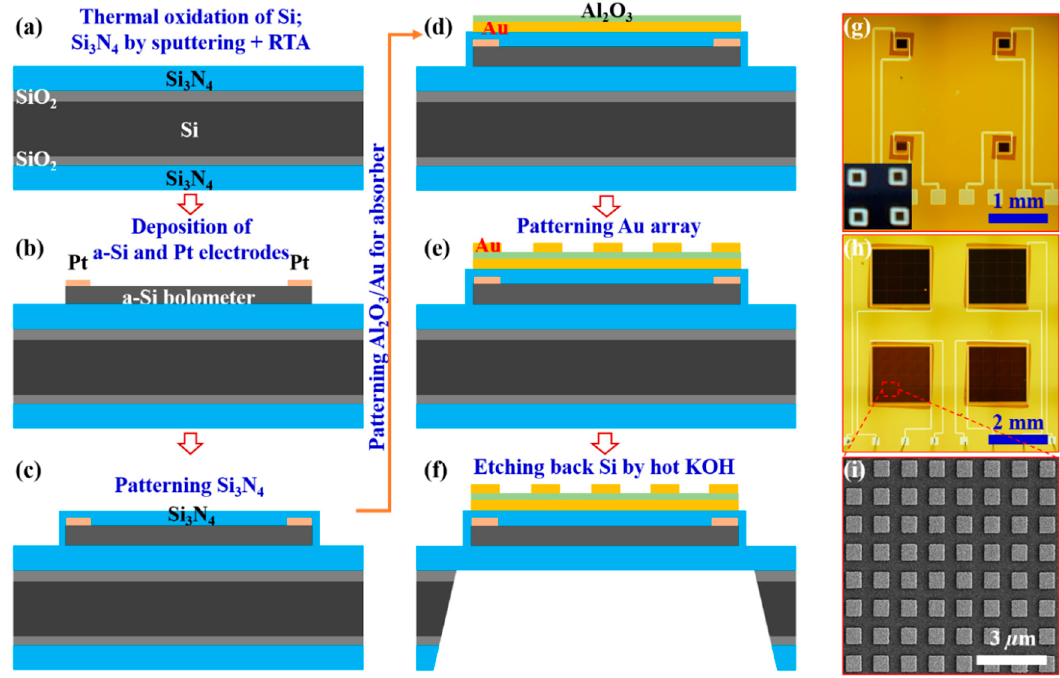
Figure 3. ( a )–( f ) Fabrication procedure of the MEMS-based wavelength-selective absorbers. ( g ) and ( h ) Top-view optical microscope images of the fabricated MEMS wavelength-selective bolometers with different square antenna sizes of the individual sensors. The inset in ( g ) reveals a photo of the MEMS-based quad-wavelength bolometer with the clear transparent Si 3 N 4 membrane around each bolometer. ( i ) Top-view SEM image of the typical MEMS sensor having a resonance 3.65 µm.